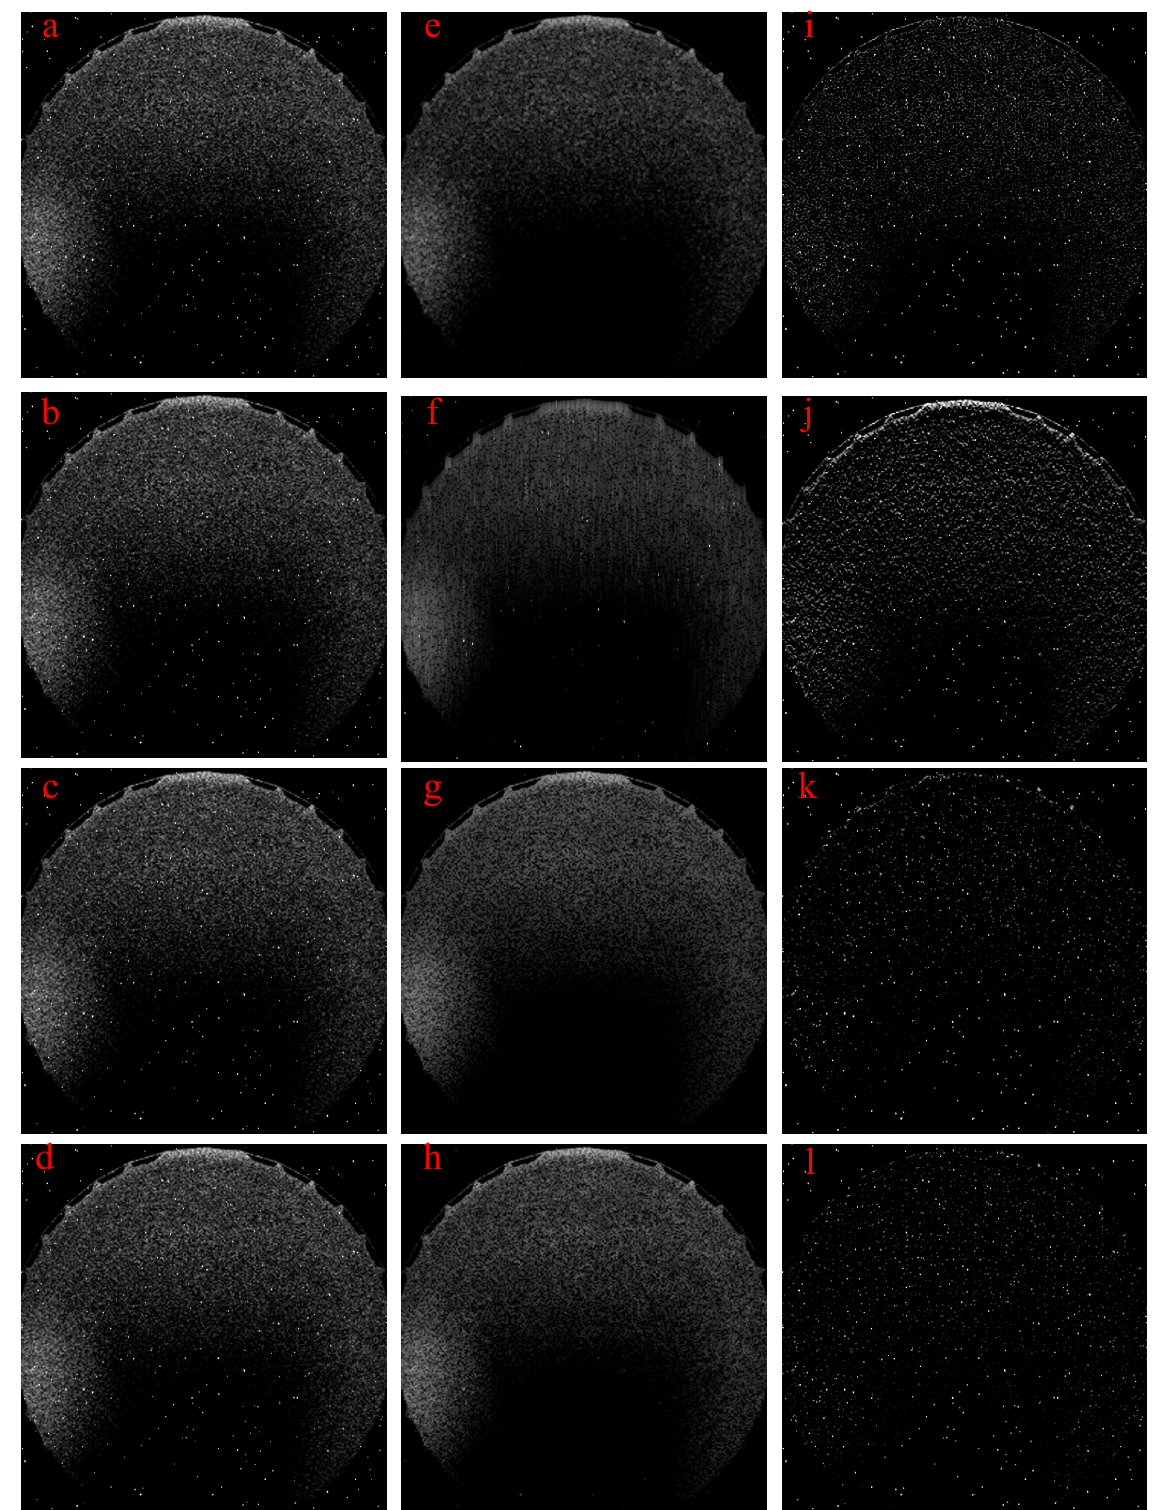
Figure 9. Elimination result for the first type of stray light background. ( a – d ) Simulated original surveillance images; ( e – h ) nonuniform backgrounds estimated by the THT, MIF, INTHT and IBSGM methods, respectively; and ( i – l ) background elimination results of the THT, MIF, INTHT, and IBSGM methods, respectively.